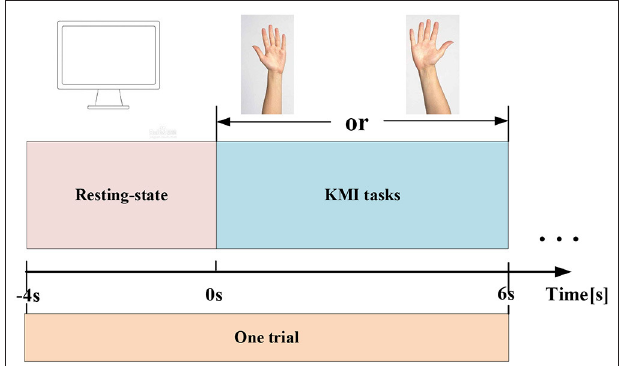
FIGURE 1 | EEG experimental paradigm. One KMI trial includes a 4-s resting state (represented by a blank screen), and a 6-s KMI task (represented by the left or right arrow on the